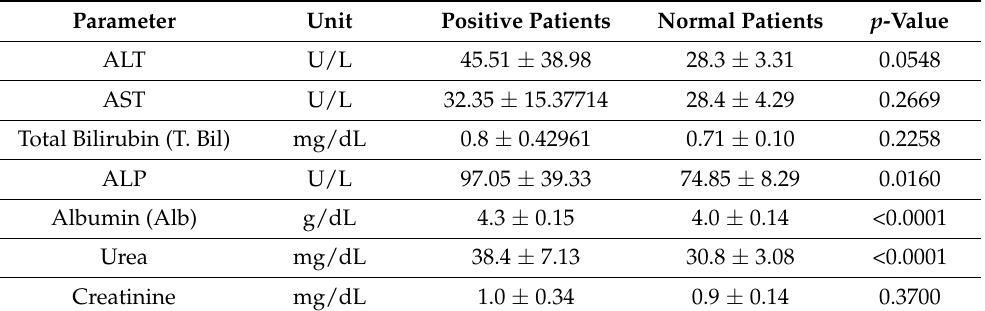
Table 6. Comparison of biochemical parameters of liver function tests and renal function tests between HIV-positive patients and healthy controls.